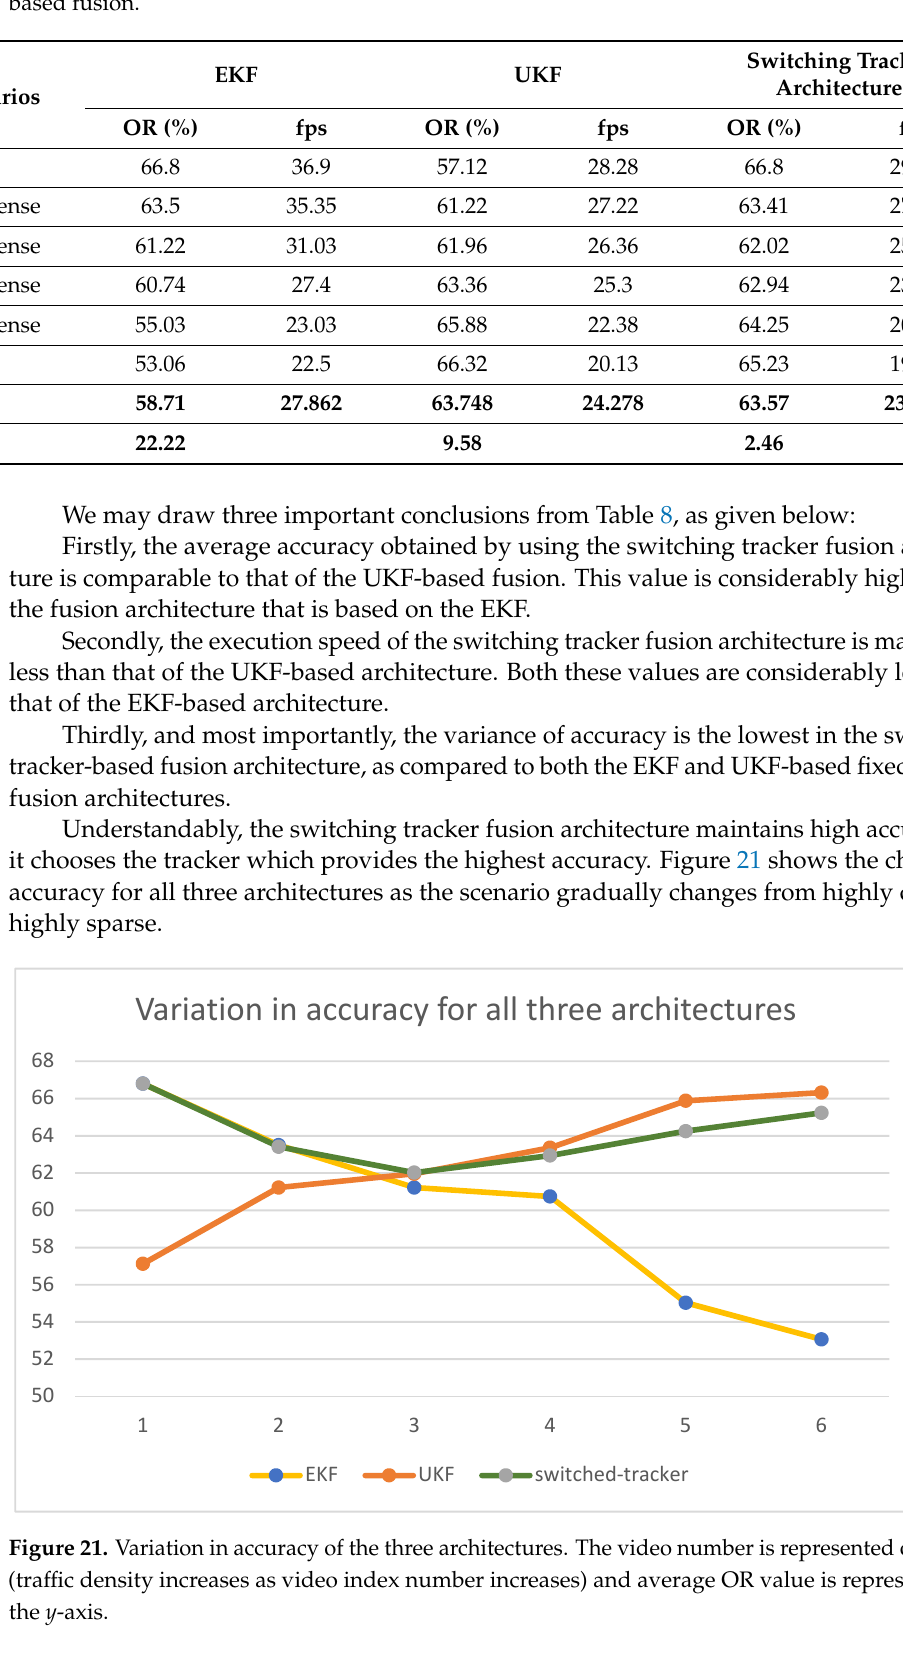
Table 8. Comparison of all 3 architectures—switched tracker-based fusion, EKF- and UKF- based fusion.